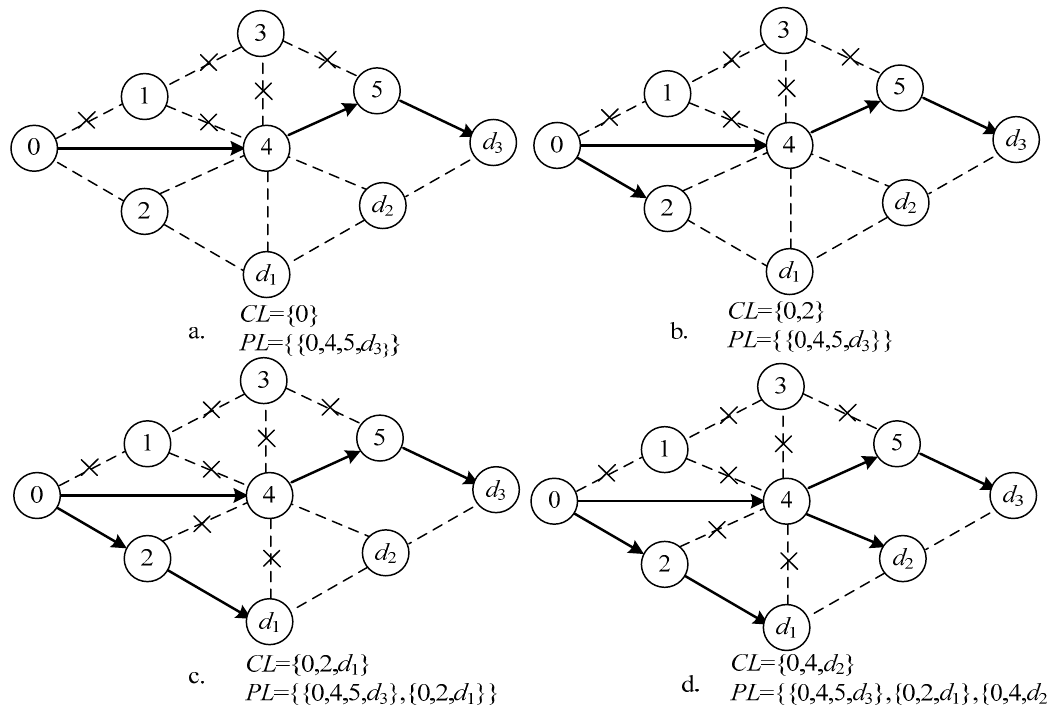
Figure 4. An instance of producing the inter-loop.